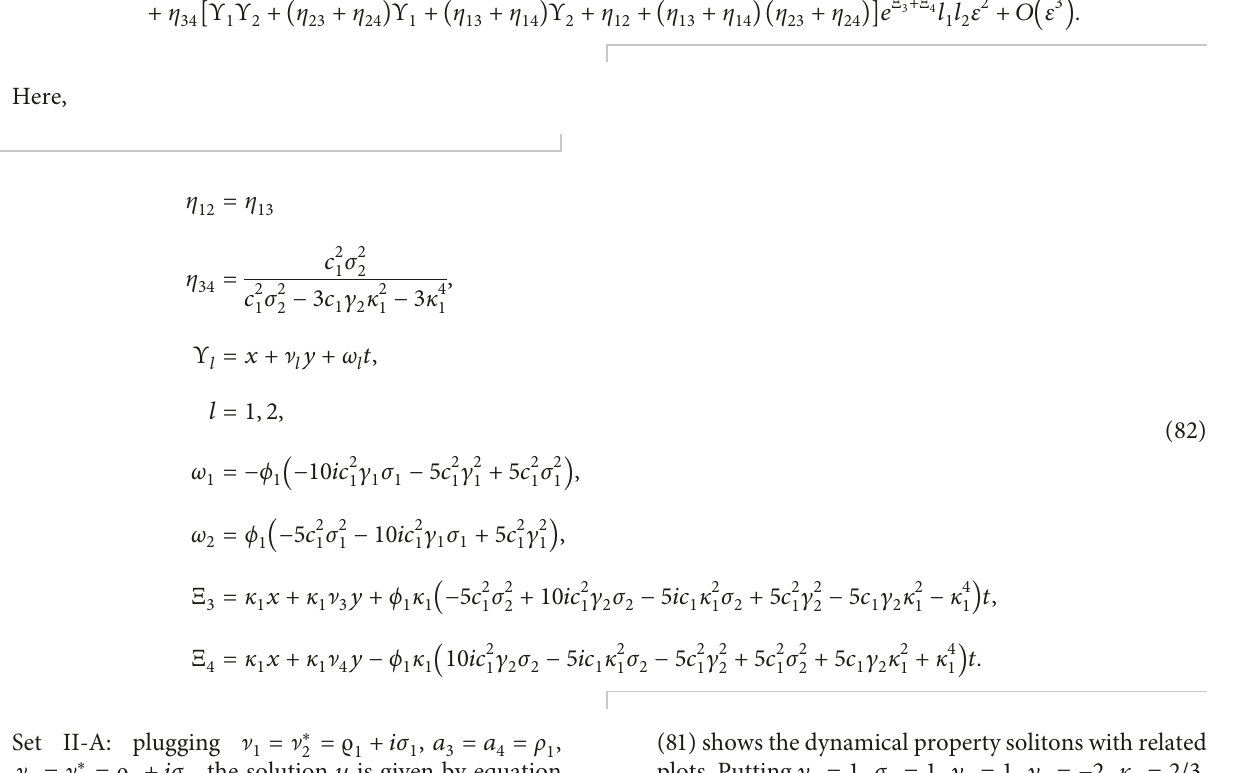
� 1 , σ � 1 , c � 1 , c � − 2 , κ � 2/3, plots. Putting c 1 1 2 3 1 the dynamical behaviors at different times are shown in Figure 20. � Option III: taking a i � l i ε , b i � a i ] i , ( i � 1 , . . . , 4 ) , ι 01 � ι � ι ∗ � i π in equation (81) and utilizing limit as ι ∗ 03 02 04 ε ⟶ 0